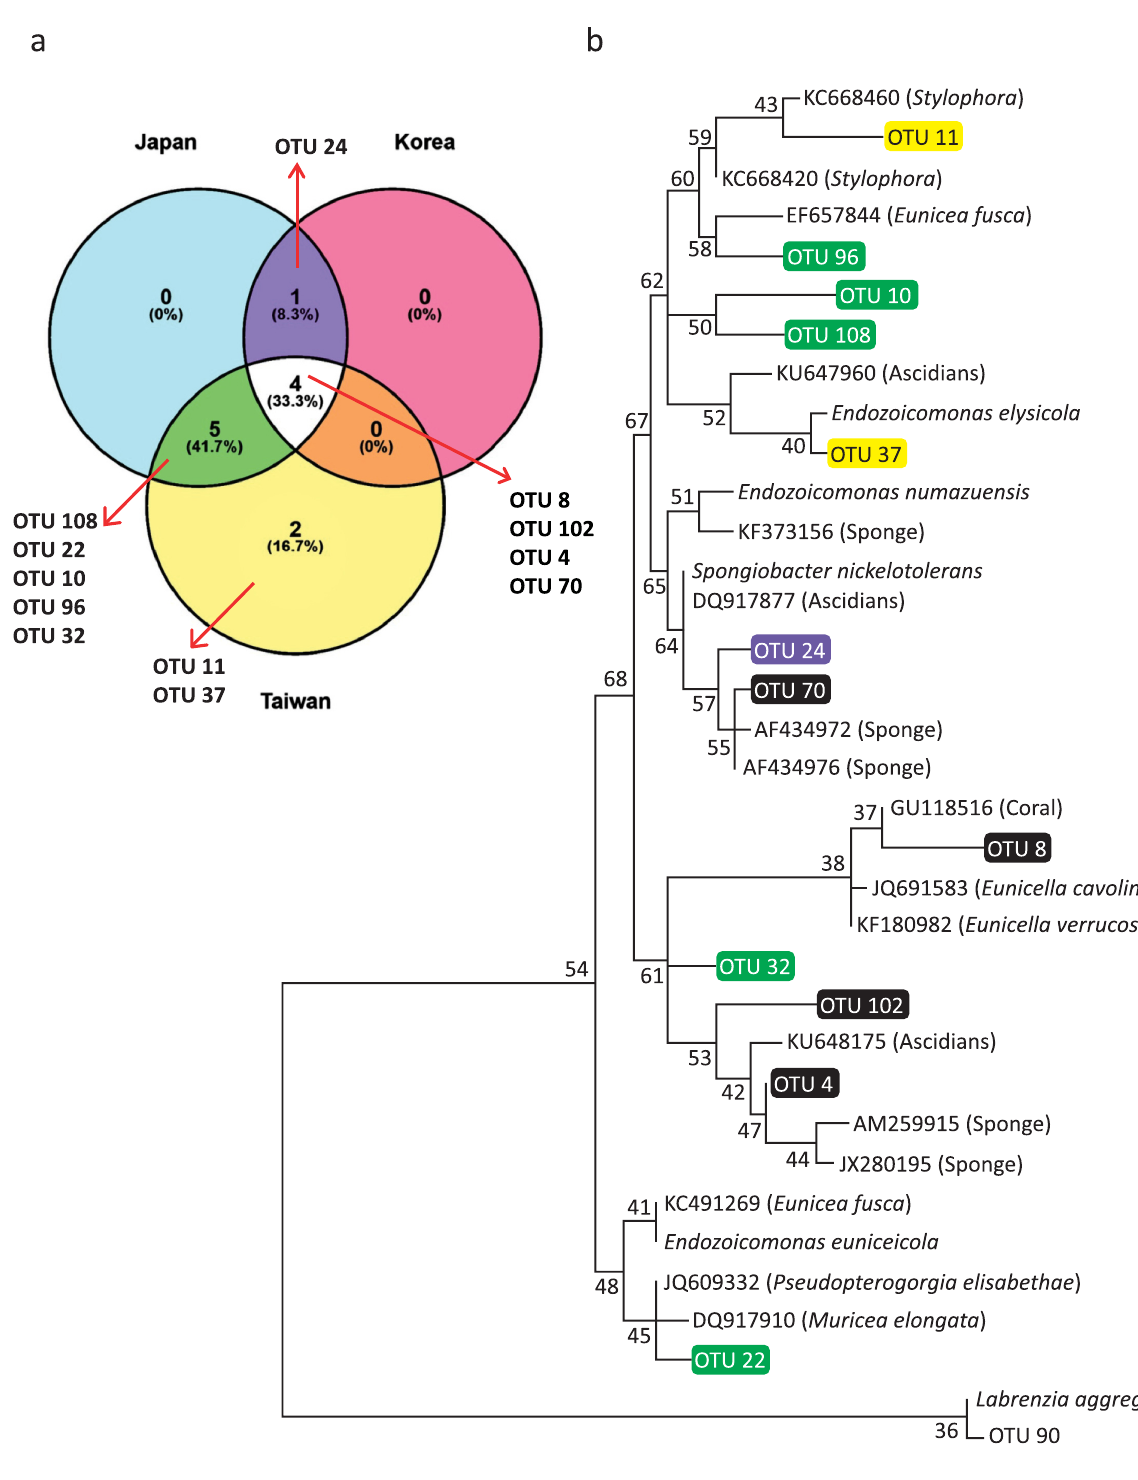
Fig 3. Venn diagrams and maximum likelihood tree for OTUs of Endozoicimonaceae associated with S . gracillimum from Korea, Japan and Taiwan. (a) Venn diagramsof Endozoicimonaceaein S . gracillimum from Korea, Japan and Taiwan. (b) The tree for